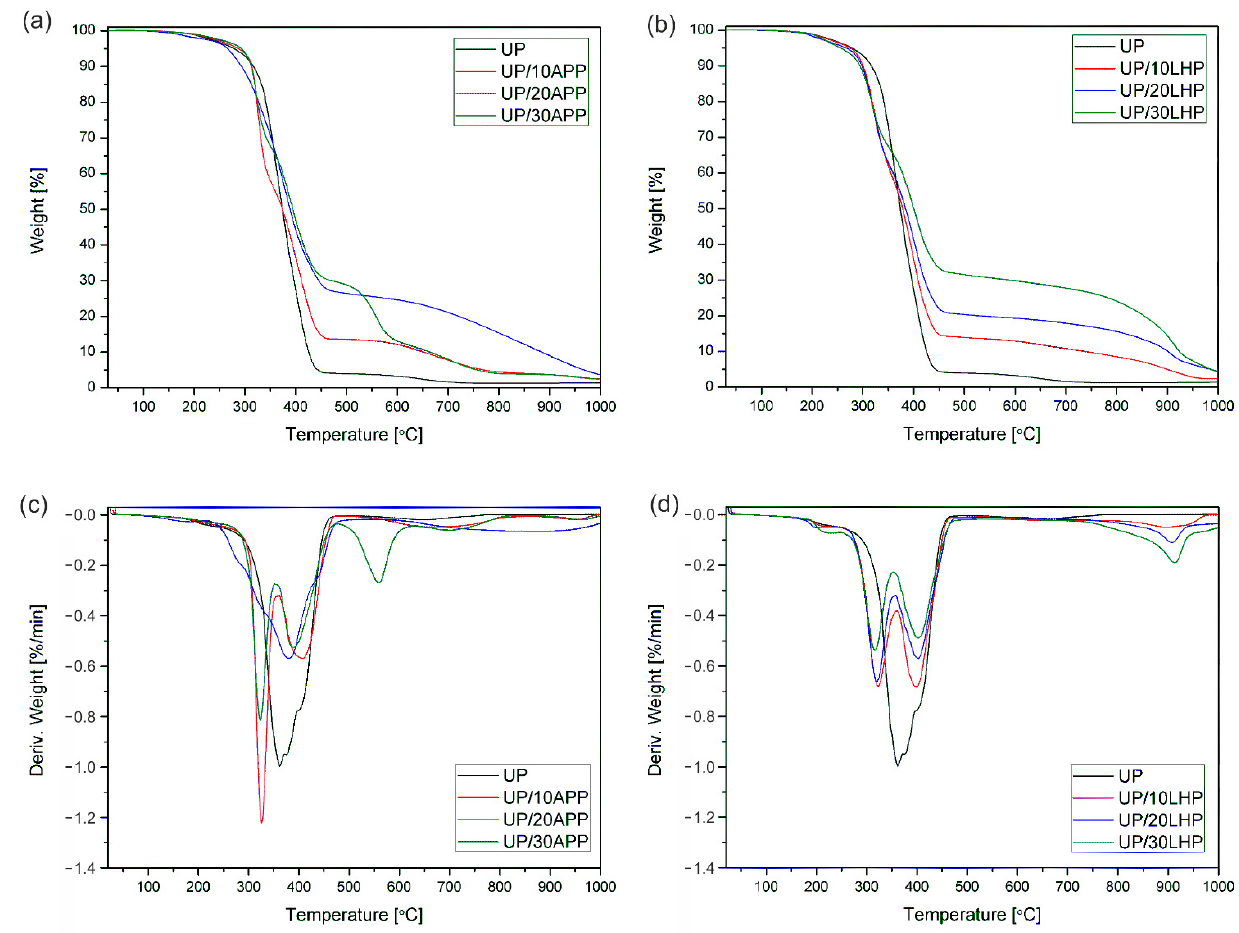
Figure 3. TG and DTG curves of UP and UP/APP ( a , c ) as well as UP/LHP ( b , d ) under an inert atmosphere.